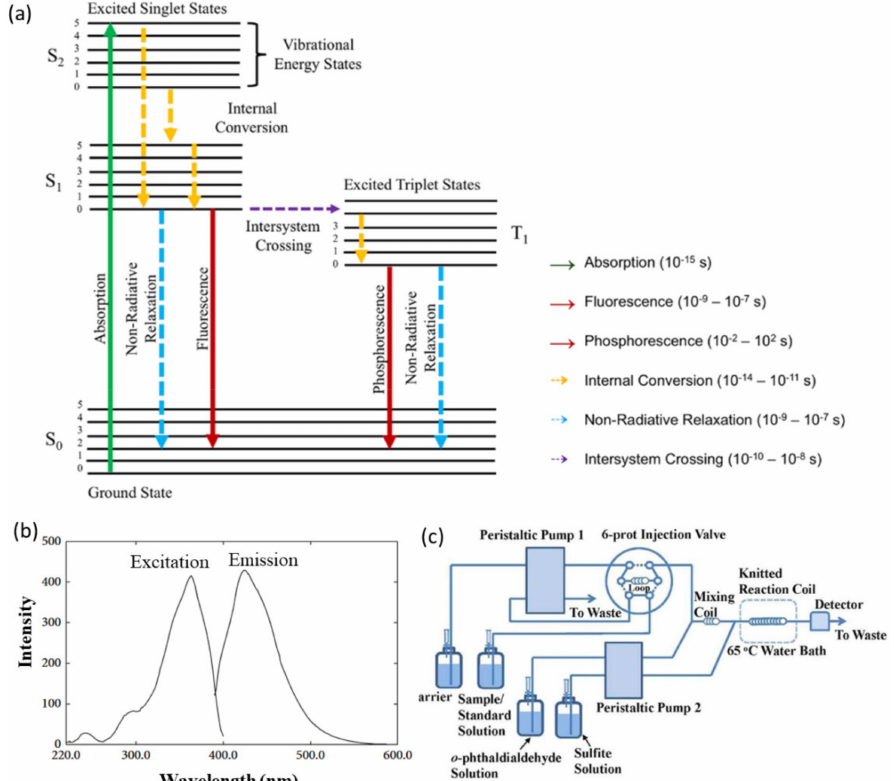
Figure 7. ( a ) Jablonski diagram. S is the singlet states (paired spin), and T is the triplet states (unpaired spin). Solid lines represent radiative processes, while dashed lines represent nonradiative